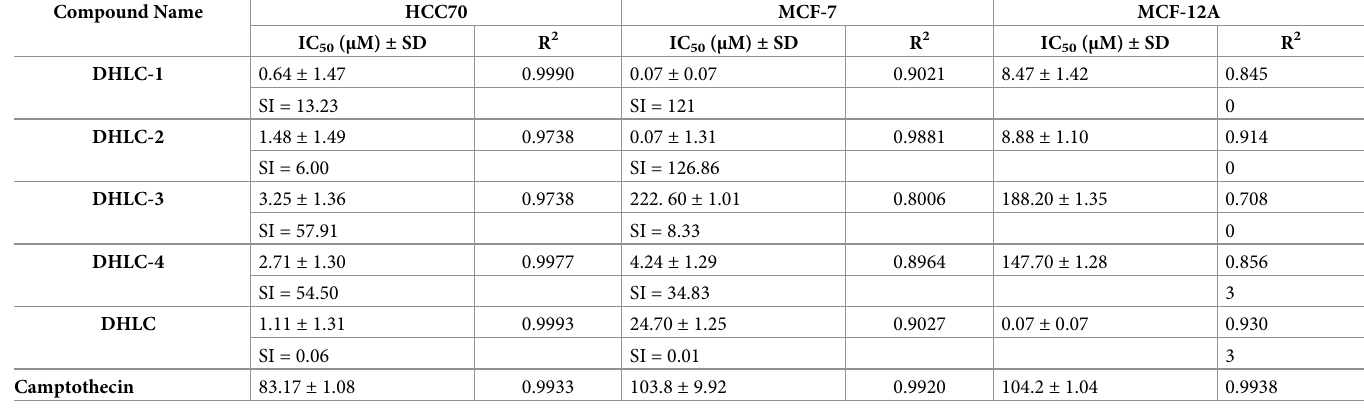
Table 2. Anticancer activities of 13-amino derivatives compounds against HCC70, MCF-7, and MCF12A cell lines. Compound